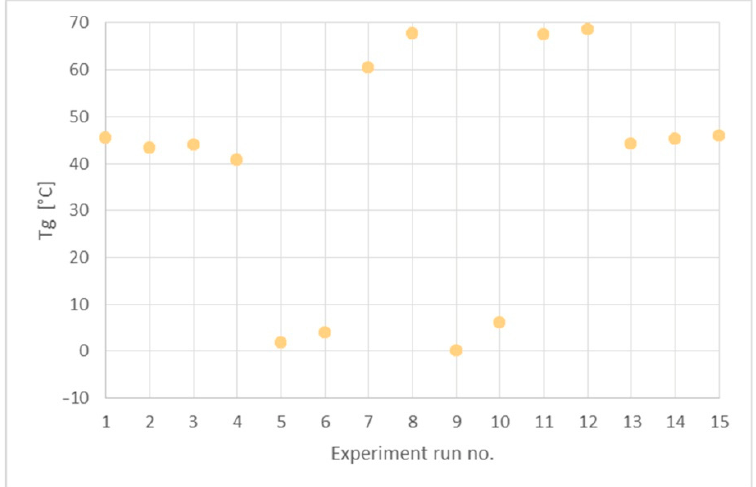
Figure 8. Glass transition temperatures (Tg) of the obtained PHUs.